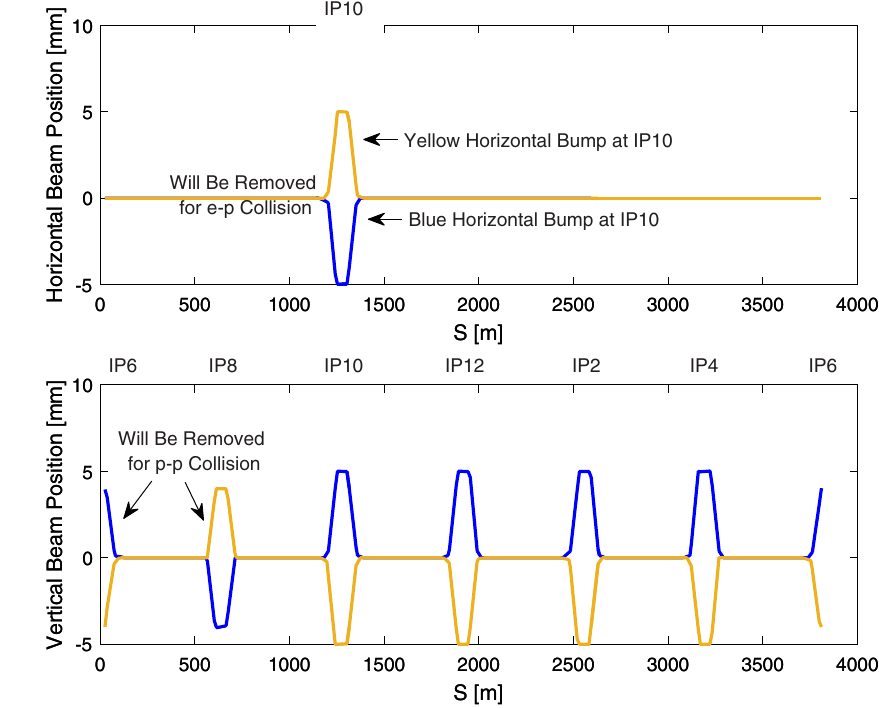
FIG. 19. Separation bump around the rings.